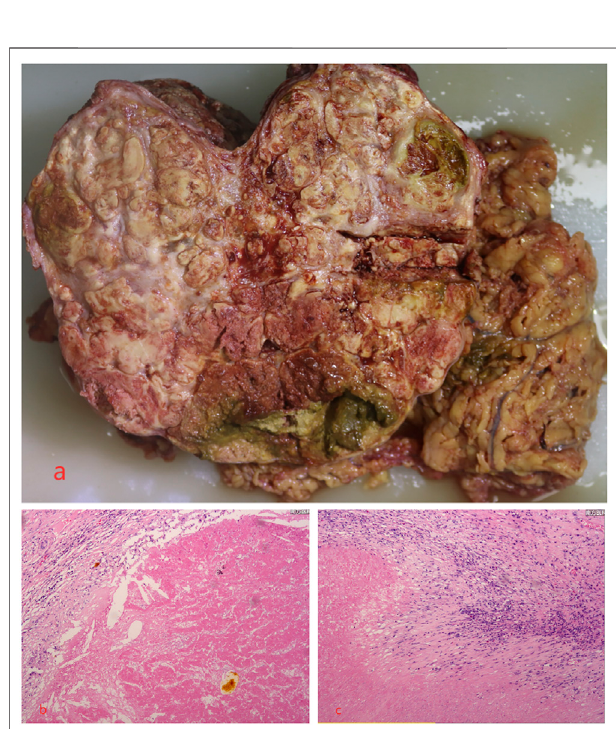
FIGURE 4 | Microscopic examination of the tumor revealed necrosis of the massive HCC with no tumor cells observed on the resection margins, and the portal vein tumor thrombus had necrotic tissue. (A) Necrosis of massive HCC; (B,C) the pathological examination.